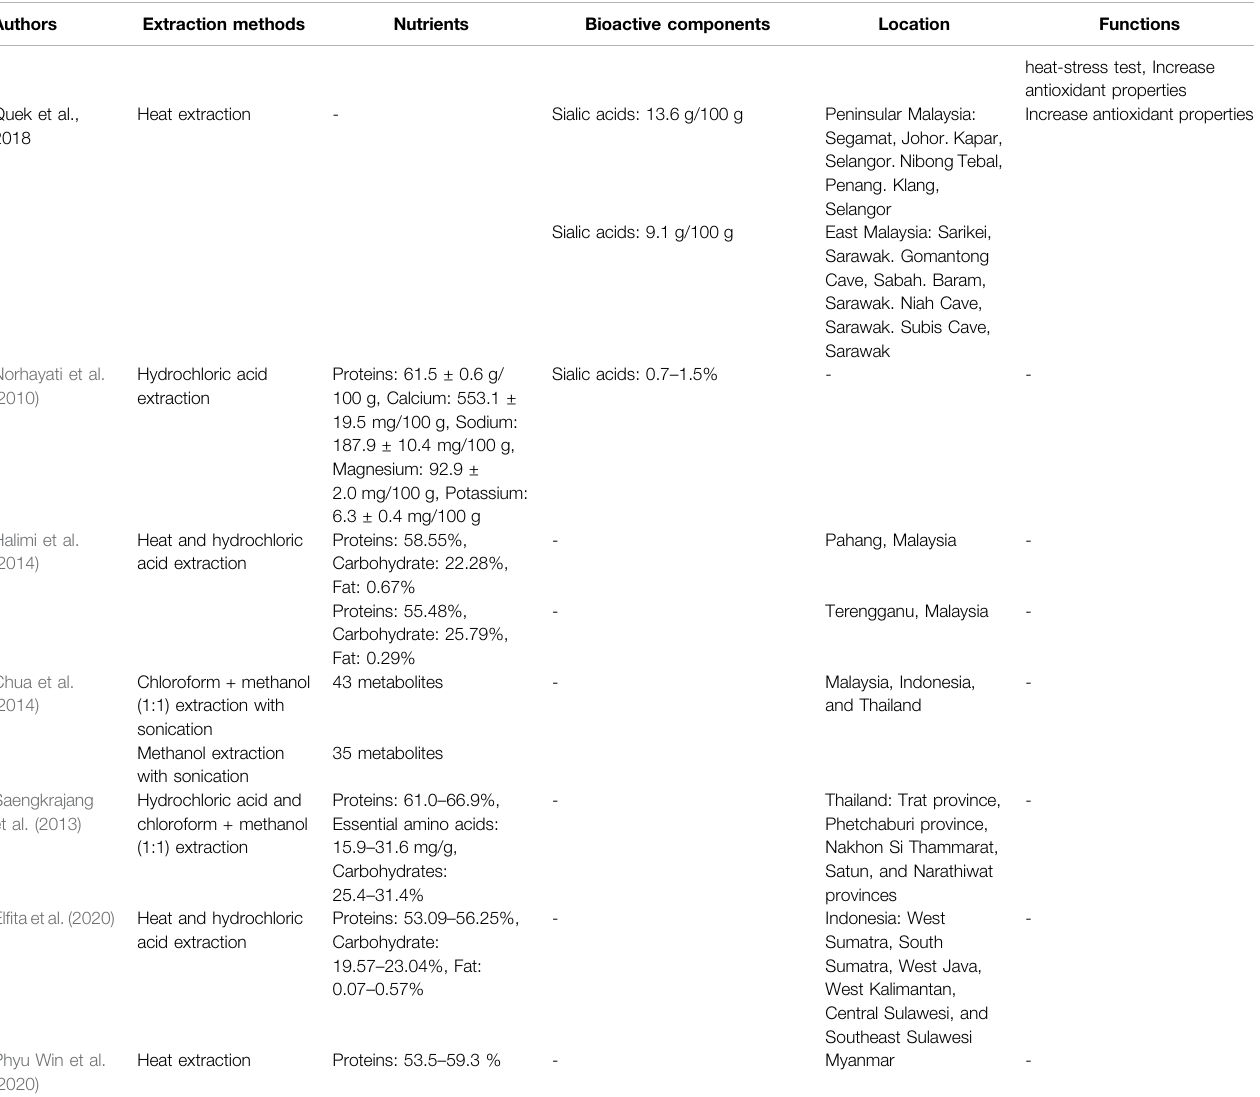
Table legend: “ - ” indicates “ not studied ” . Glucosamine (UDP-N-acetyl)-2-epimerase/N-acetylmannosamine kinase (GNE), ST8 alpha-N-acetyl-neuraminide alpha-2,8-sialyltransferase (ST8SiaIV), solute carrier family 17 member 5 (SLC17A5), and brain derived neurotrophic factor (BDNF).